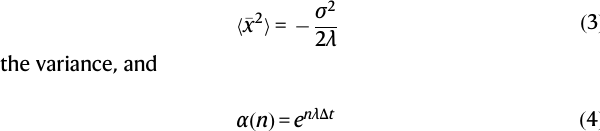
Fig.4|Vegetationresilienceasafunctionofprecipitationseasonalityinterms of the Walsh-Lawler seasonality index 32 (Methods), separated by land-cover type 46 . Vegetation resilience λ estimated empirically ( A , B ) and via the AC1 ( C , D ) for vegetation optical depth (VOD, left column) and MODIS NDVI (right column). Binned medians shown as solid dots (Kendall-Tau (KT) p <0.05) and transparent arrows (KT p >0.05), with 25 – 75th percentiles of each bin shown as connected vertical lines capped with hatches. Land covers with less than 1000 points or less than 10 bins of at least 50 members are omitted. E KT coef fi cients (aridity vs AC1- derived λ ,panels C , D )foreachland-covertype.Signi fi cant( p <0.05)KTsshownas a black triangle (KT of median binned data, cf. C , D ), insigni fi cant relationships